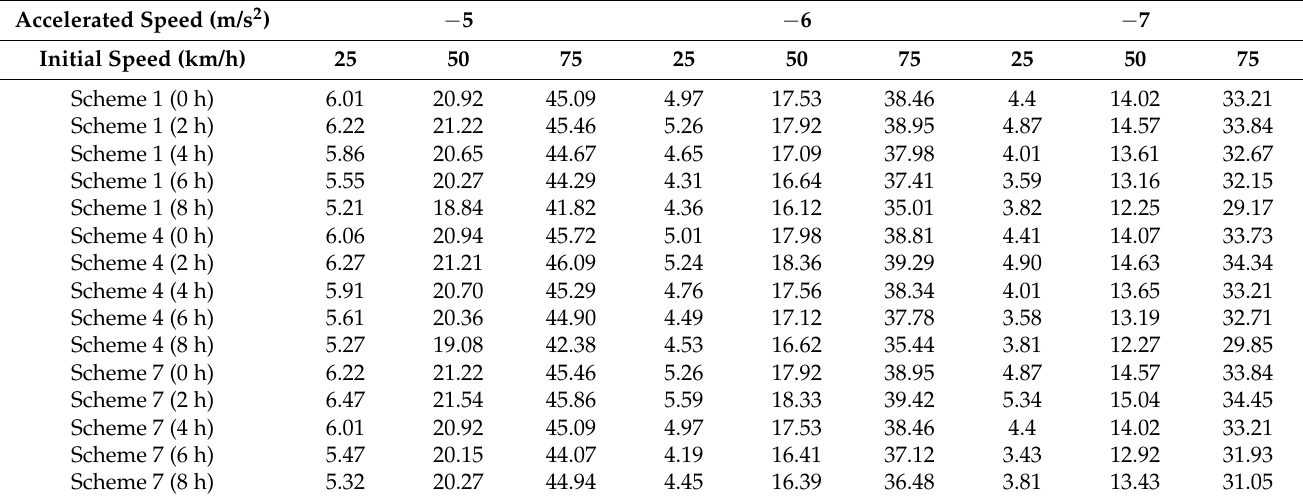
Table 6. Results for braking distance on dry pavement